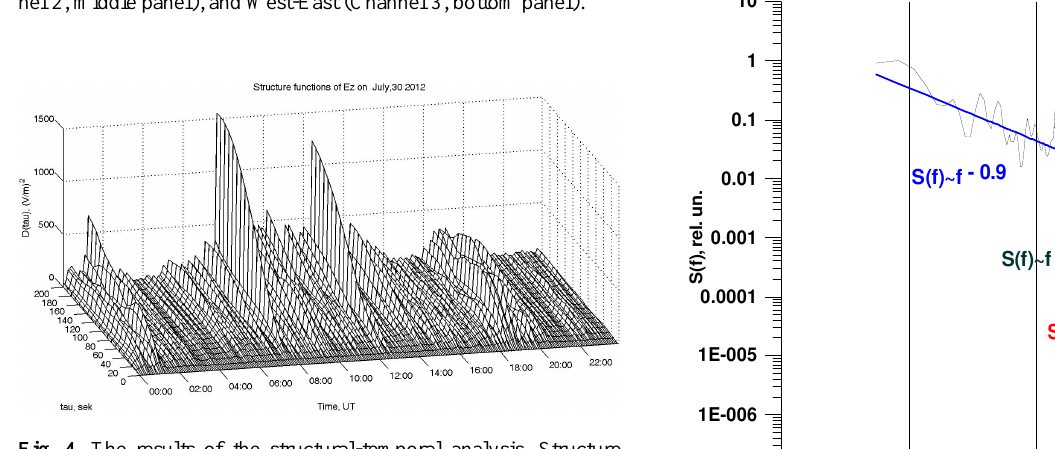
Fig. 4. The results of the structural-temporal analysis. Structure functions are shown for 30 July. Figure 4. The results of structure-temporal analysis. Structure functions are shown for July 30.